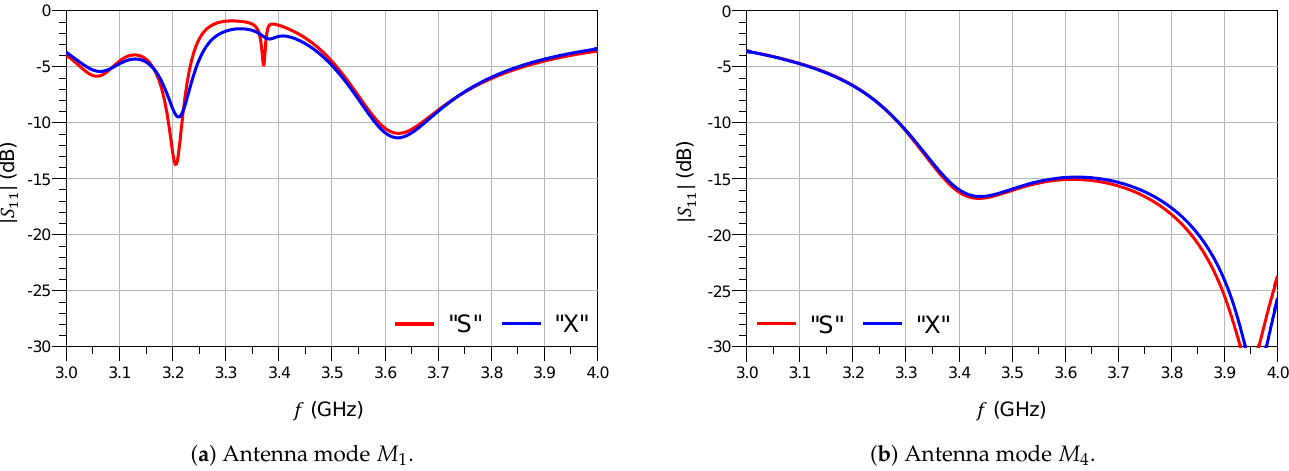
Figure 7. Port match in a test reconfigurable